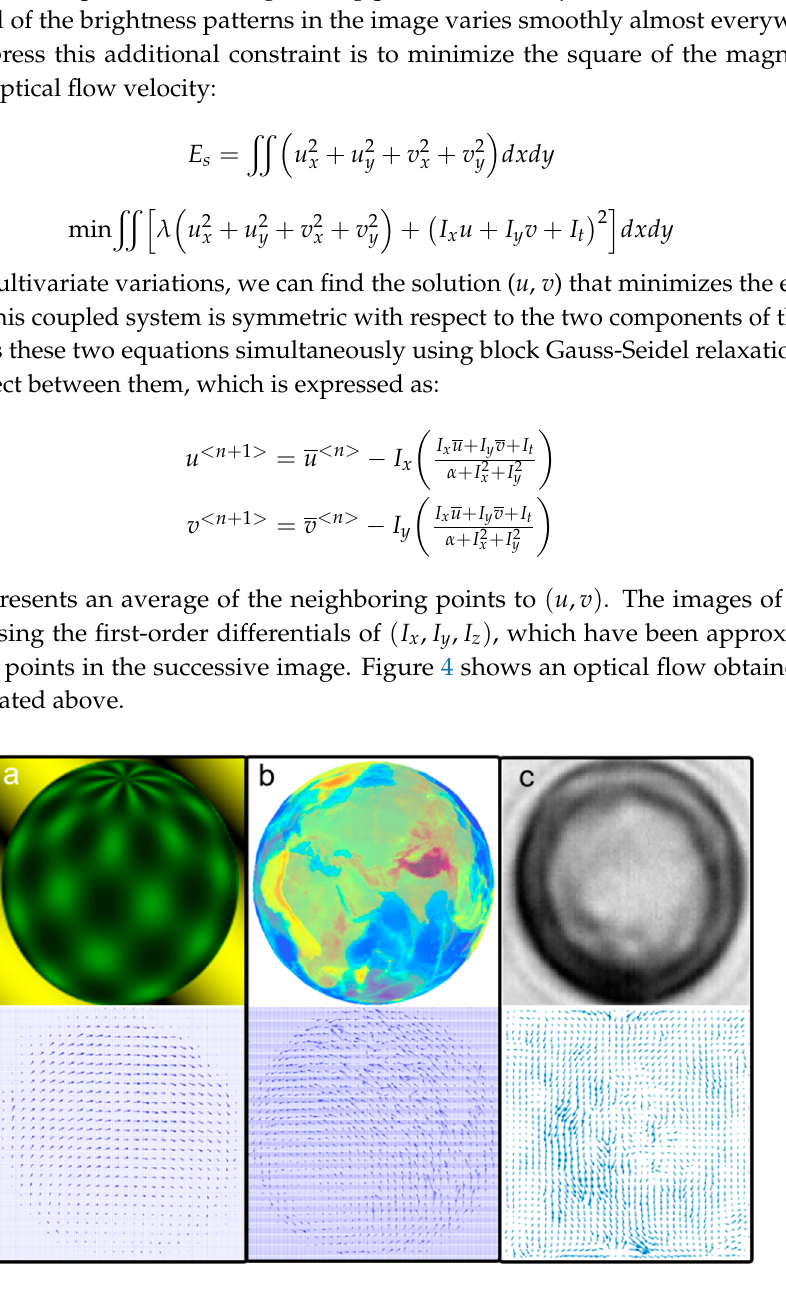
Figure 4. Image templates and their optical flow results. ( a ) Baker’s test template (126 × 126 pixels); ( b ) Earth globe test sequence (207 × 207 pixels); and ( c ) cell rotation sequence (101 × 101 pixels).